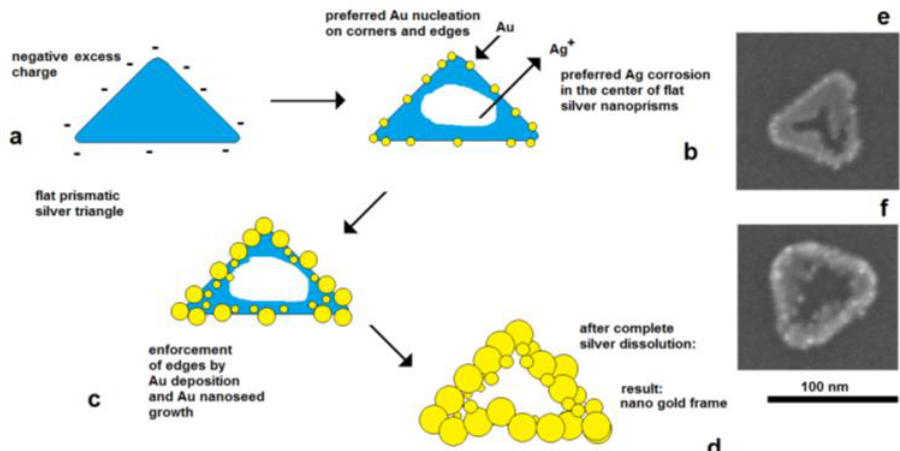
Figure 9. Electrically controlled formation of metal frame particles by the substitution of a less-noble metal by a noble metal.